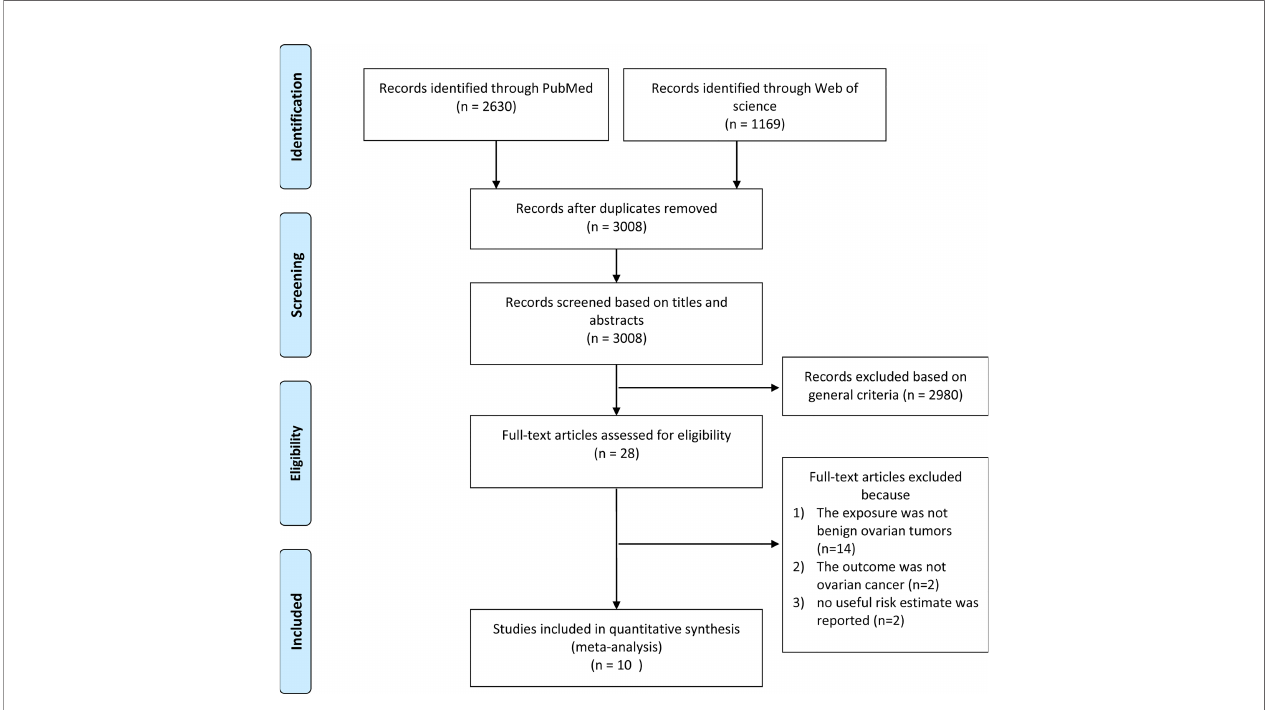
FIGURE 1 | Flow diagram of study